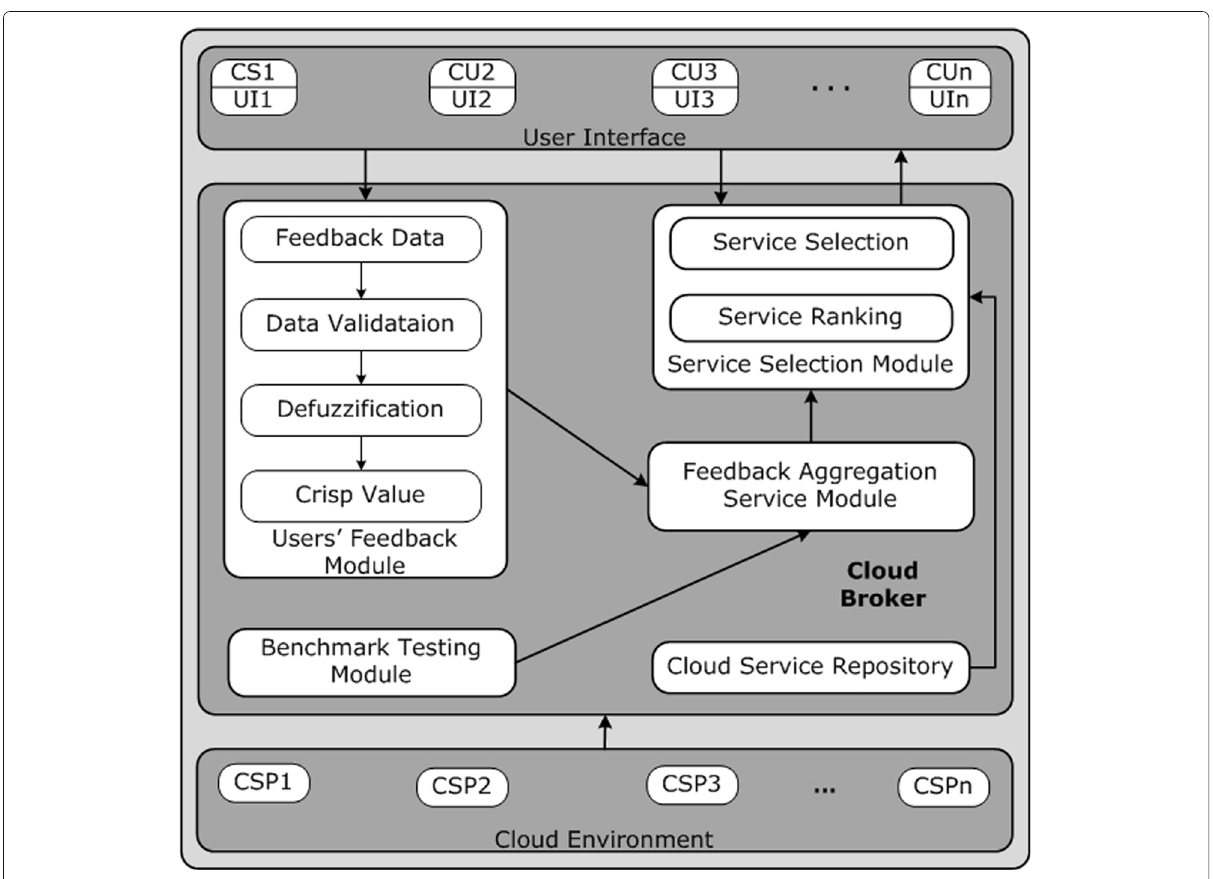
Fig. 1 Cloud Service Selection